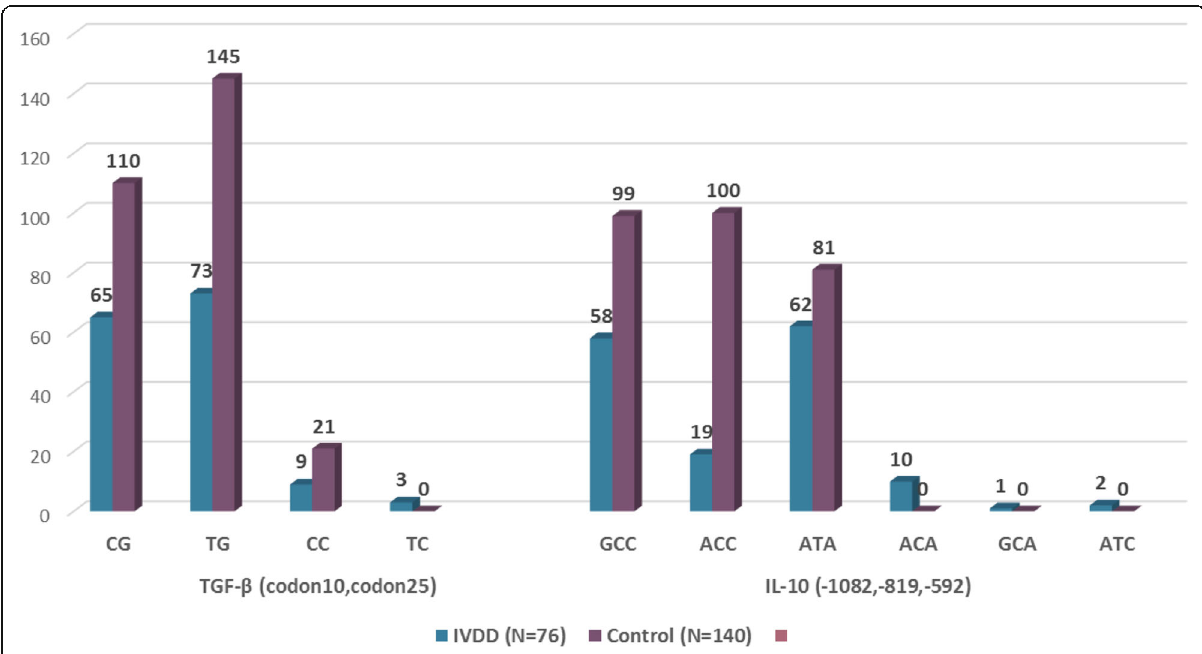
Fig. 3 Haplotype Frequencies of IL-10 and TGF- β SNPs in IVDD and